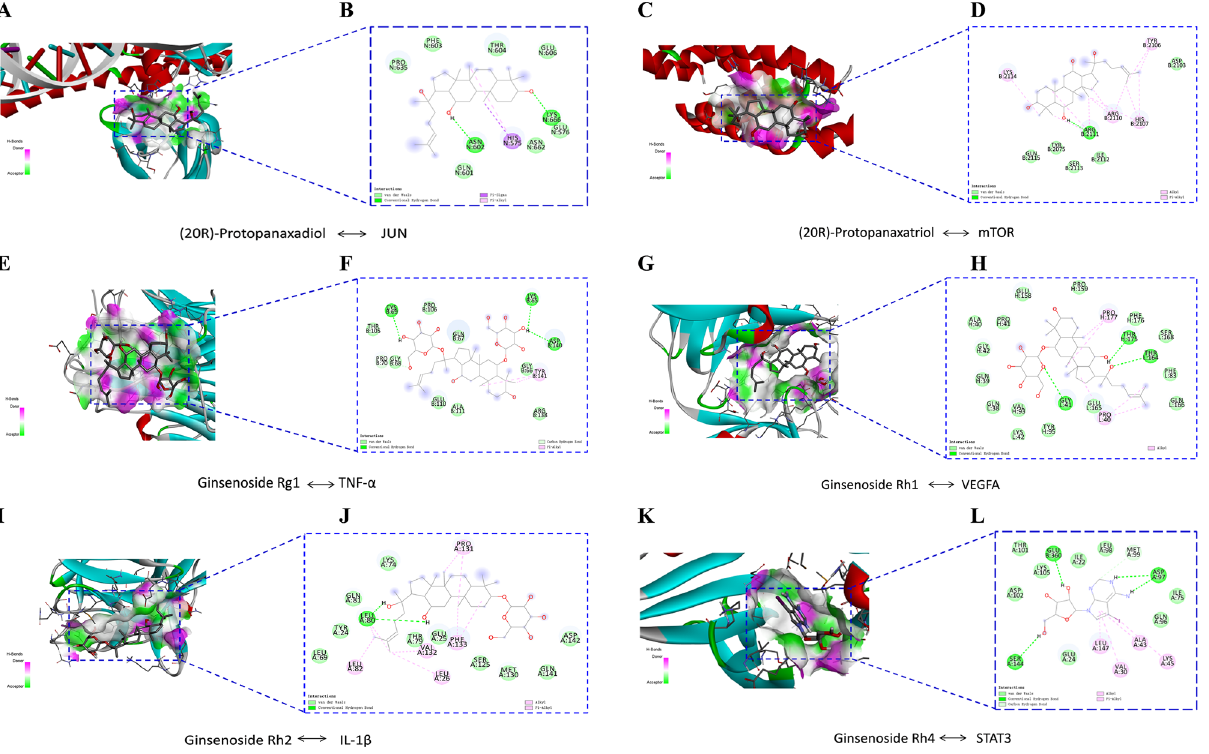
Figure 5. Molecular docking analysis showing bond pattern. 20(R)-Protopanaxadiol with JUN ( A , B ), 20(R)-Protopanaxatriol with mTOR ( C , D ), Ginsenoside Rg1 with TNF-α, ( E , F ), Ginsenoside Rh1 with VEGFA ( G , H ), Ginsenoside Rh2 with IL-1β ( I , J ), Ginsenoside Rh4 STAT3 ( K , L ). Areas of the donor and acceptor of hydrogen bond (H-bond) ( A , C , E , G , I , K ). 2D patterns of bond ( B , D , F , H , J , L